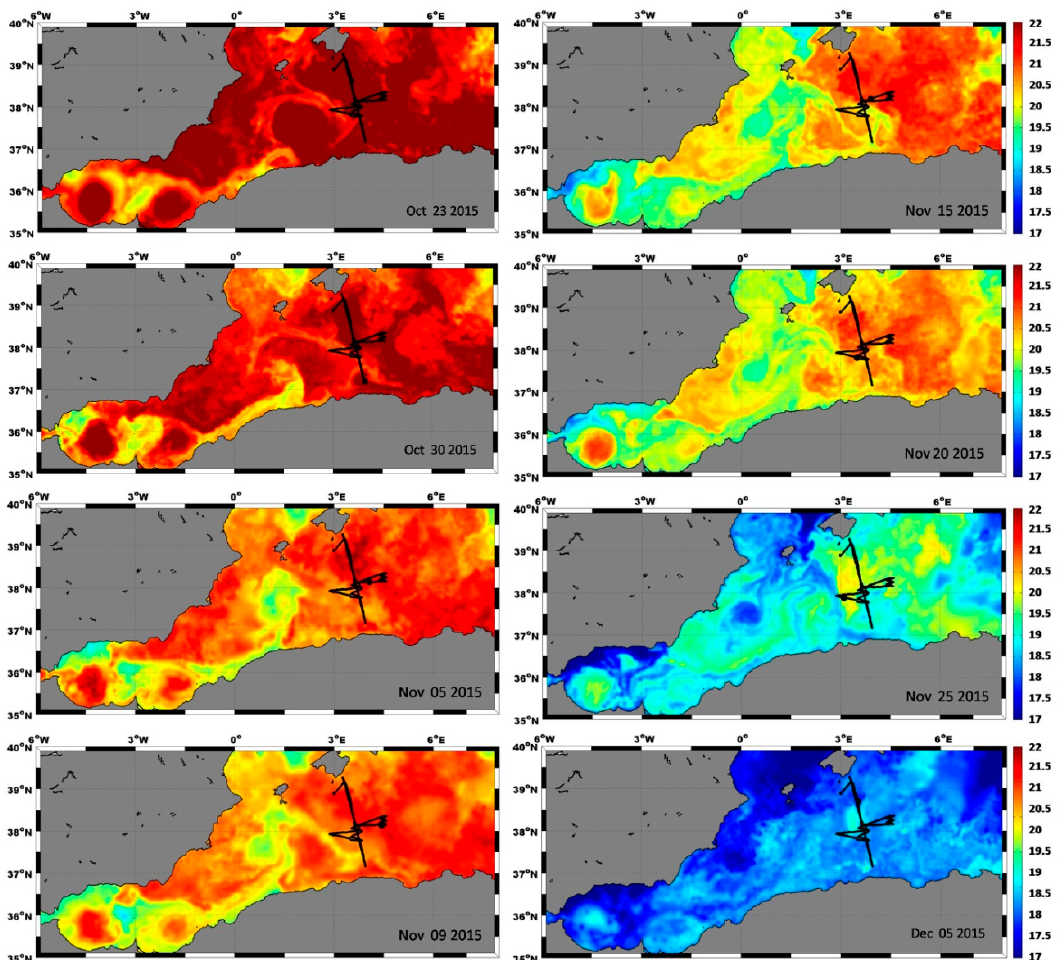
Figure 12. Ultra-high-resolution SST maps of the Alboran Sea and the Algerian Basin on eight representative dates of the ABACUS 2 survey. Glider track in black. Large black dots represent glider location on each date. ADT in meters. A different colorscale is used for October maps in order to highlight the observed ocean surface features.